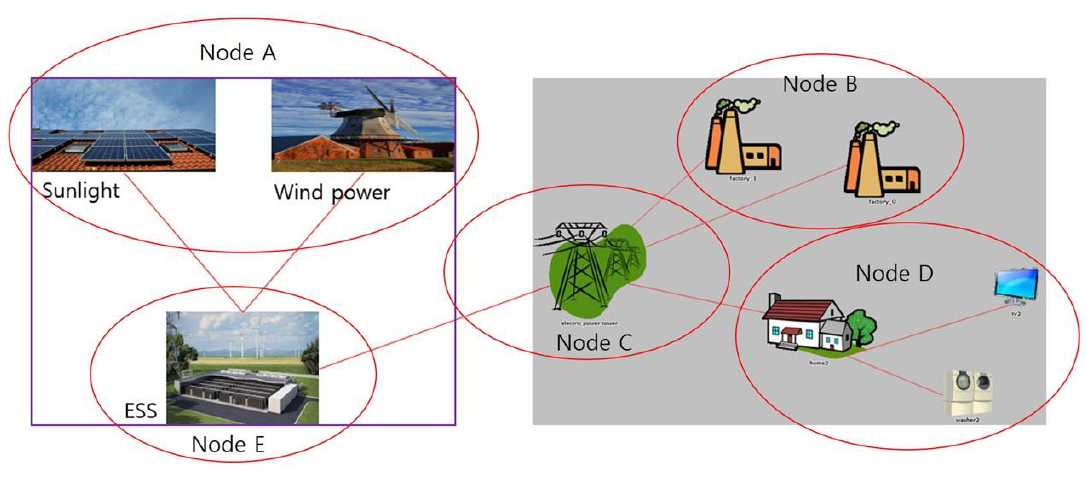
Figure 11. Test Bed Scenario Setup.